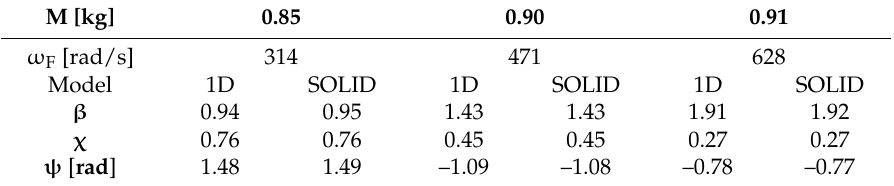
Table 11. Amplification factors and phase angles of the law of motions for the three considered